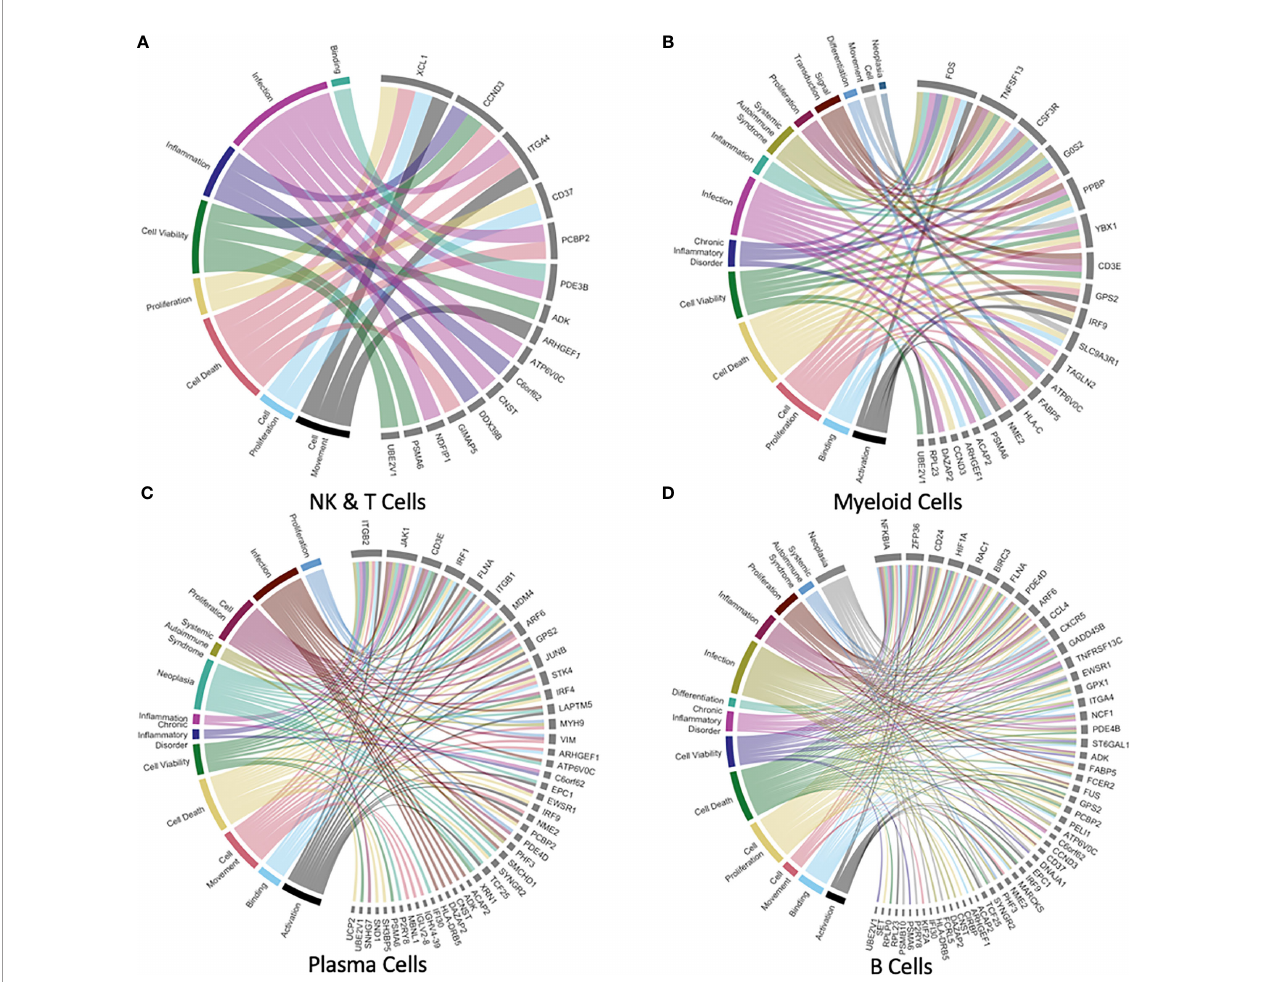
FIGURE 6 | Gene meta-signatures reveal the expression landscape of immune homeostasis in the human liver immune meta-atlas. (A – D) Chord plots representing 8-14 immune cell-speci fi c diseases or functions (Systemic Autoimmune Syndrome, Signal Transduction, Proliferation, Neoplasia, In fl ammation, Infection, Differentiation, Chronic In fl ammatory Disorder, Cell Viability, Cell Death, Cell Proliferation, Cell Movement, Binding, Activation) with links to the respective genes which have been identi fi ed as DE between the liver leukocyte subpopulation listed versus the corresponding PBMC leukocyte